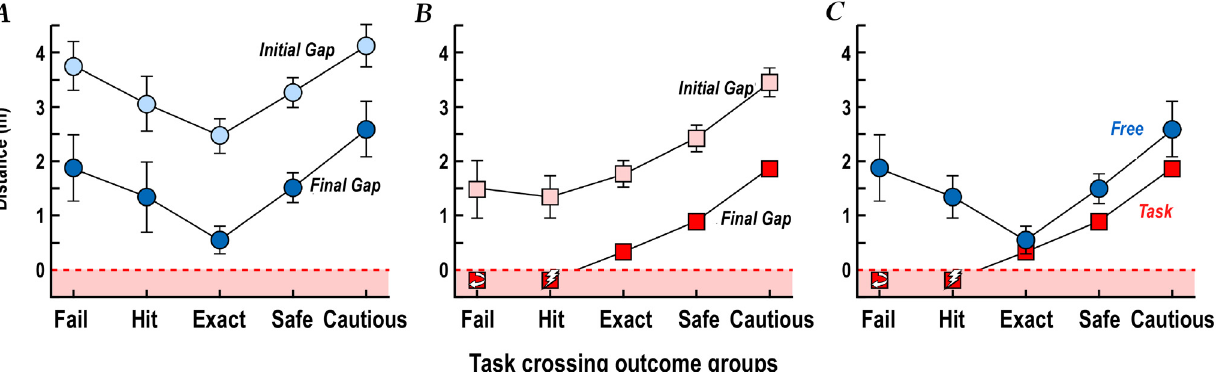
Fig 3. Initial and final gap distances by crossing group. A. Initial gap and final gap distances (mean ± SEM) for the five road-crossing groups are plotted for the free crossing. B. When participants had the additional task, smaller clearance distances were allowed by all groups. Those that were hit or failed in the task crossing left larger clearances in the free crossing. They behaved like those in the safe and cautious groups. C. Comparison of the final gap distances for the free and task crossings.